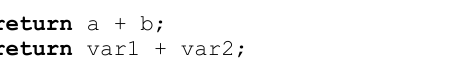
Fig. 4. Second bytecode fragment decompilation